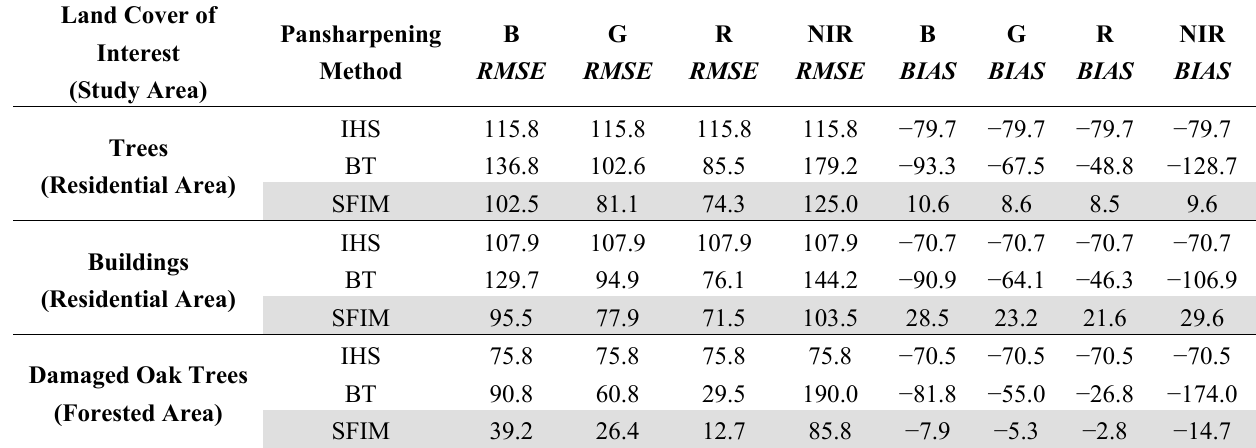
Table 2. RMSE and BIAS of the most spatially-accurate segmentations for each pansharpening method. The pansharpening method with the highest spectral accuracy ( i.e. , lowest RMSE and BIAS ) is highlighted in gray.